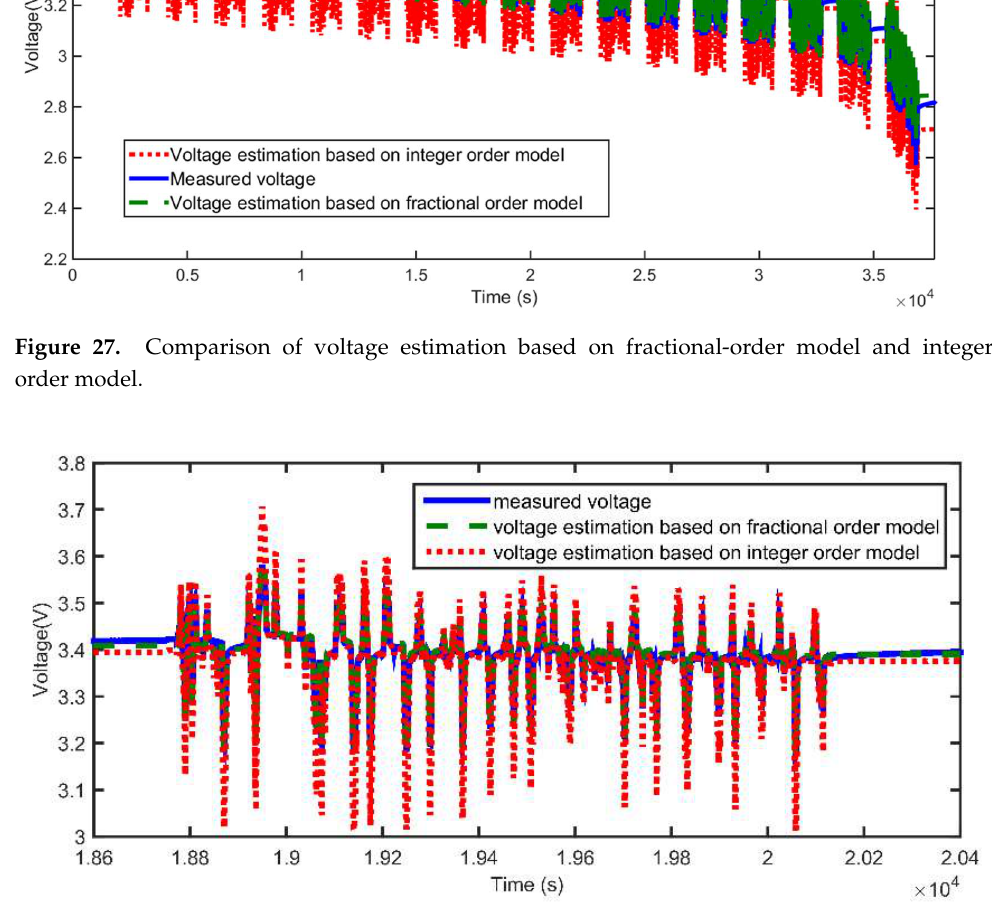
Figure 28. Comparison and enlargement of voltage estimation based on fractional-order model and integer-order model.